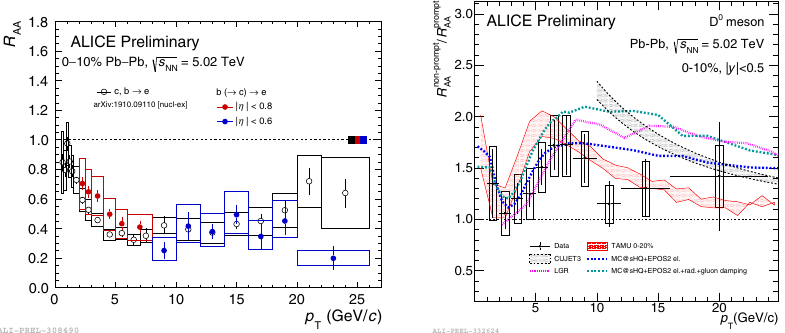
Figure 2. Left: Comparison of the R AA of electrons from heavy-flavor hadron and beauty-hadron decays in Pb–Pb collisions at √ s NN = 5 . 02TeV. Right: Ratio of non-prompt D 0 to prompt D 0 R AA in Pb–Pb collisions at √ s NN = 5 . 02TeV, compared to model predictions.